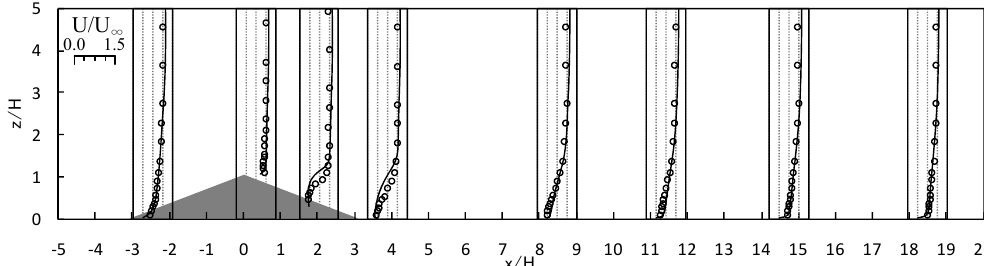
Fig. 2. Turbulence characteristics of approaching flow.